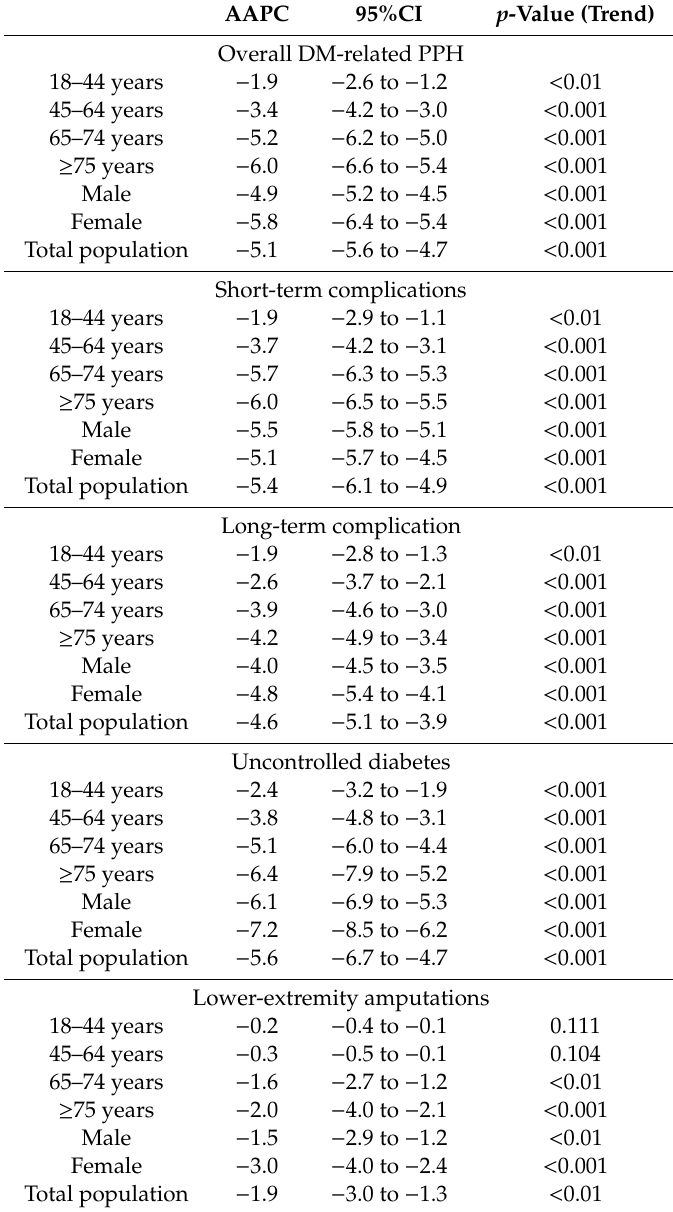
Table 1. Annual average percentage change of diabetes-related potentially preventable hospitalizations: overall and stratified by age and sex